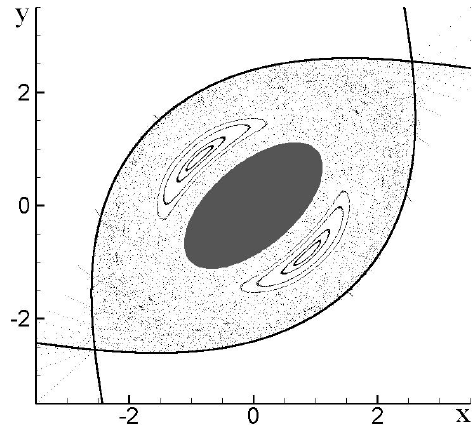
= 2, θ ( 0 ) = π with b( 0 ) 4